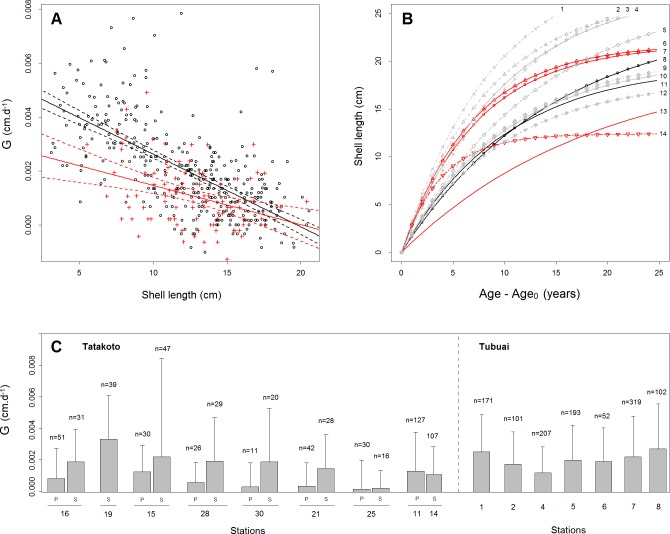
Growth rate and growth curve of giant clams for the two studied sites.(A) Predicted means (solid lines) and confidence intervals (dashed lines) for growth rate (G) as a function of mean shell length for Tridacna maxima at Tatakoto (red, n = 93) and Tubuai (black, n = 352). Shell growth rate G (cm.d-1) is the ratio between shell length increment and number of days between two measurements (see methods). (B) Growth curves obtained from data collected in this study (curve n°13 for Tatakoto and curve n°11 for Tubuai) and information gleaned from the literature. 1: Papua New-Guinea [28]; 2: Tonga [23]; 3: Solitary islands [29]; 4: Rose atoll [30]; 5: One Tree Island [21]; 6: Fangatau [18]; 7: Tatakoto [18]; 8: Tubuai [18]; 9: Aitutaki [25]; 10: Manihiki [25]; 12: Suwarrow [25]; 14: Takapoto [31]. (C) G (mean ± SD) estimated from sampling at each station. Stations are further subdivided into a deep site (P) and a shallow site (S) at Tatakoto.